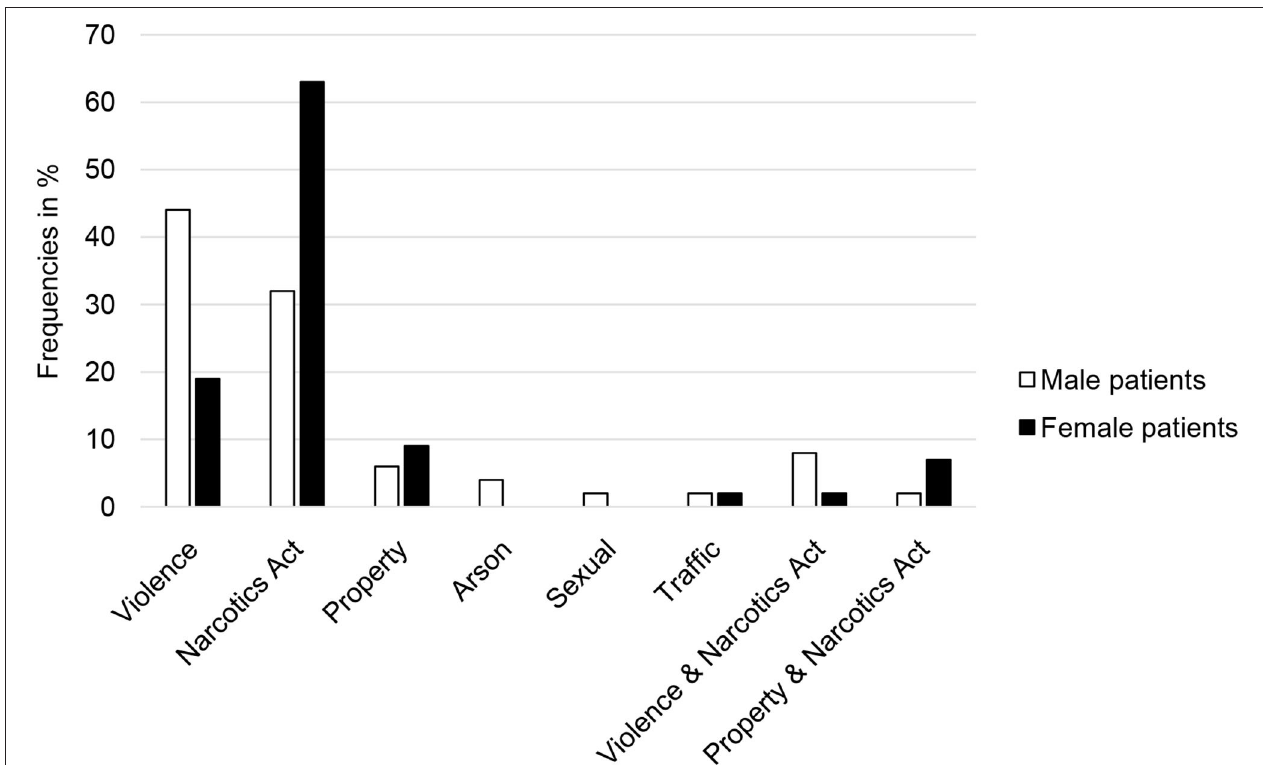
FIGURE 4 | Frequencies (in percent) of the various index offenses in male ( n = 115) and female ( n = 64) inpatients in forensic psychiatric treatment for substance use